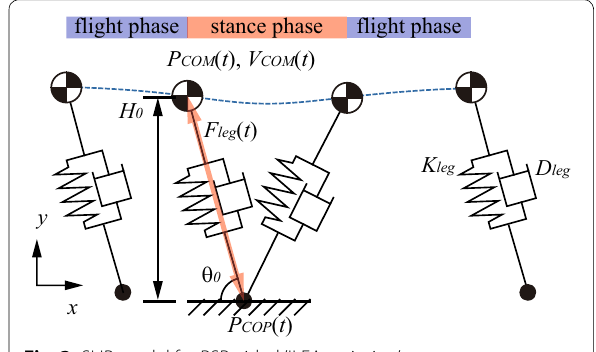
Fig. 3 SLIP model for RSP-aided ’ILEA sprinting’